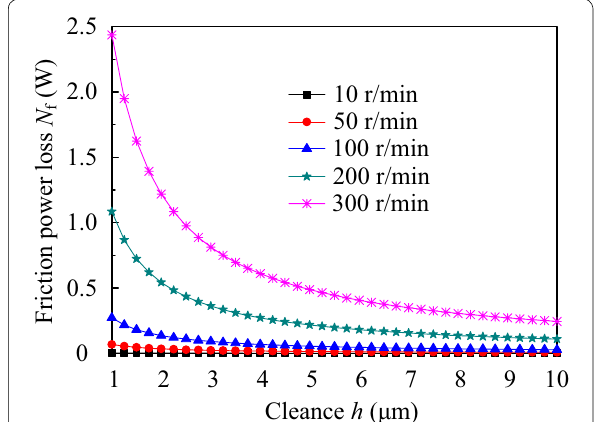
Figure 6 Change of total power loss with clearance at various rotating speed